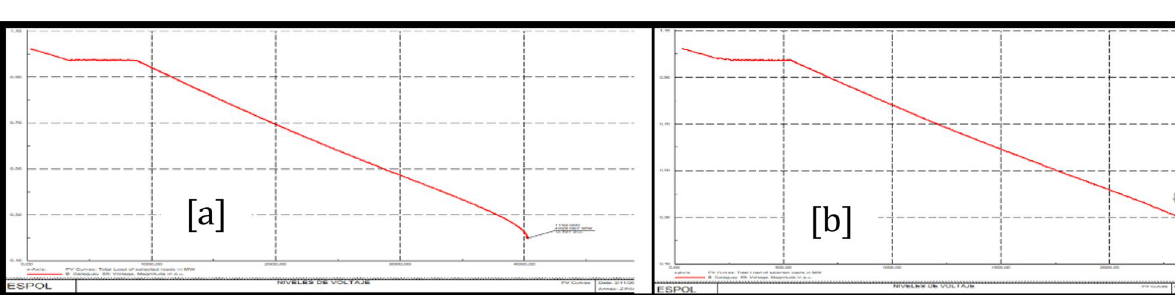
Figure 10. Stability PV before load model ( a ) and PV after load model ( b ) Trinitaria area.